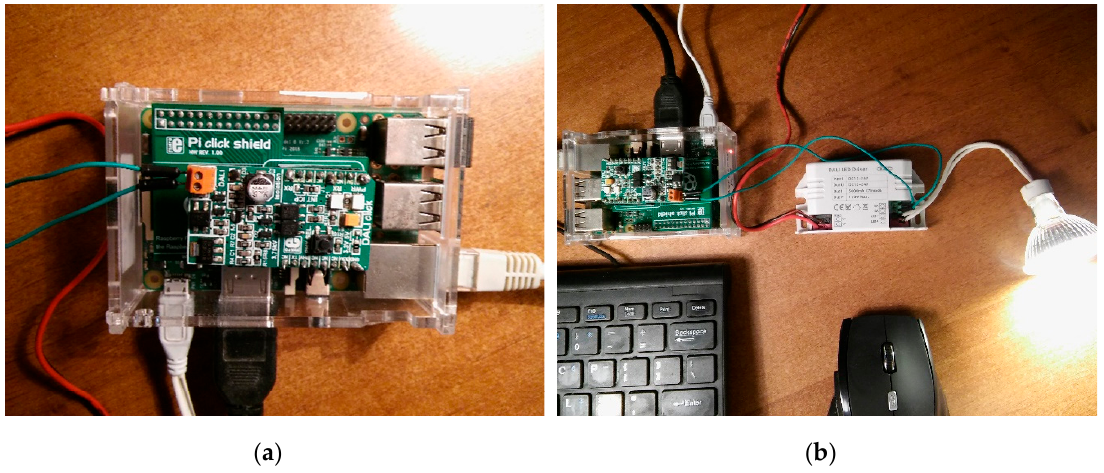
Figure 5. ( a ) RPi3, Pi Click and DALI Click shield; ( b ) the overall DALI LED Driver control system.